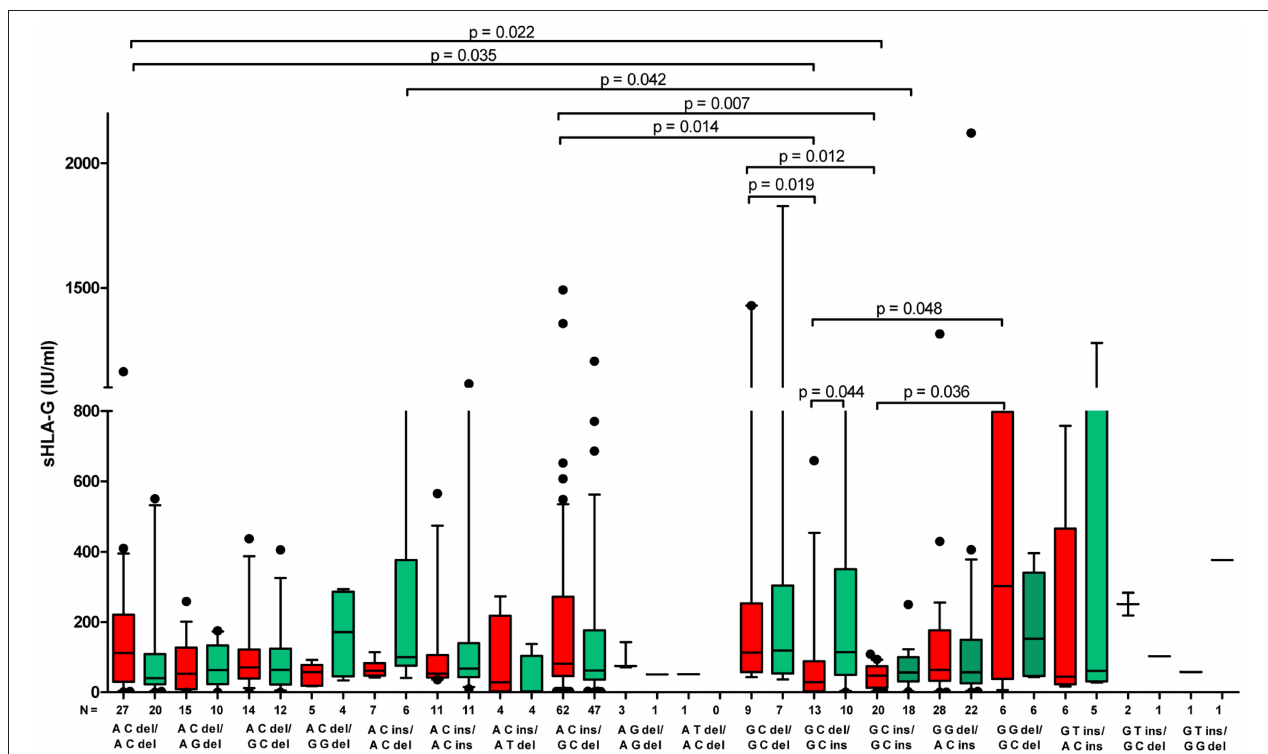
FIGURE 5 | Concentration of soluble HLA-G per milliliter of plasma (IU/ml) measured before and after embryo transfer in all patients according to their HLA-G diplotypes. Diplotypes were determined from haplotype analysis and estimated in the following order: rs1632947: − 964G > A; rs1233334: − 725G > C/T; rs371194629:insATTTGTTCATGCCT/del. Red boxes represent the level of sHLA-G measured before embryo transfer and green boxes, after embryo transfer. Boxes are drawn from the first quartile (25th percentile) to the third quartile (75th percentile). Black lines in boxes are medians. Whiskers represent 10–90 percentiles. N is the number of patients. p -values are calculated by Mann–Whitney test. Comparison of diplotypes G C del/G C del, G C del/G C ins, and G C ins/G C ins by Kruskal–Wallis test, p =